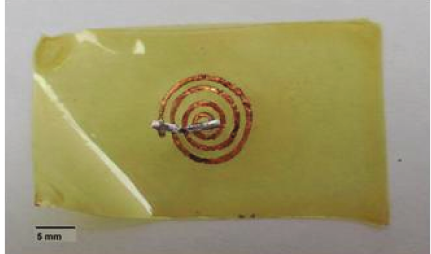
Figure 9: Passive RLC tank circuit with polyimide coating.